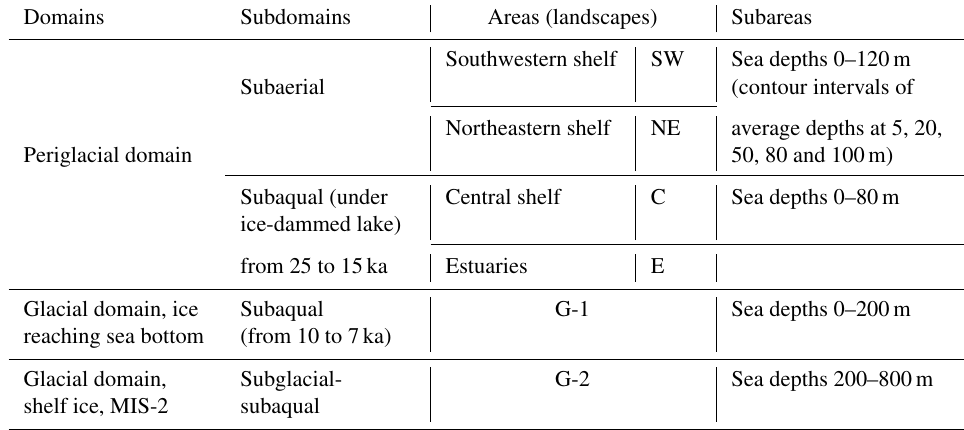
Glacial domain, ice reaching sea